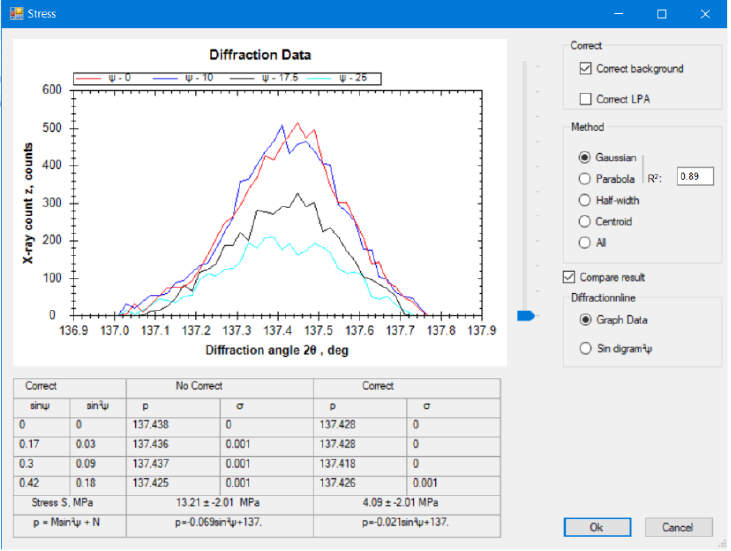
Figure 7. Peak positions and stress determination of aluminum alloy 1060.